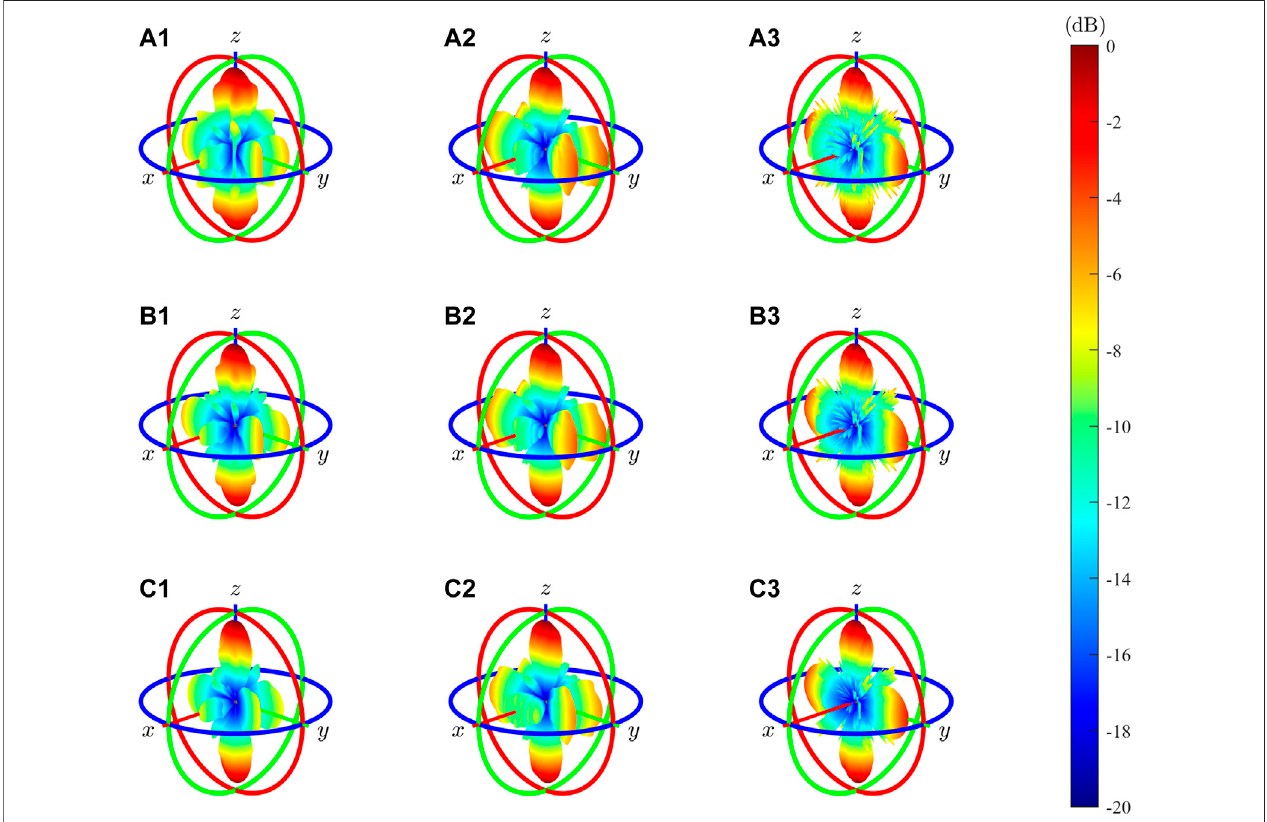
FIGURE12| Stararray ’ sbeampatternsusingthebeamformers: (A) maxWNG, (B) tradeoff,and (C) maxdirectivity,forseveralfrequencies: (1) 2 kHz, (2) 5 kHz,and (3) 8 kHz.